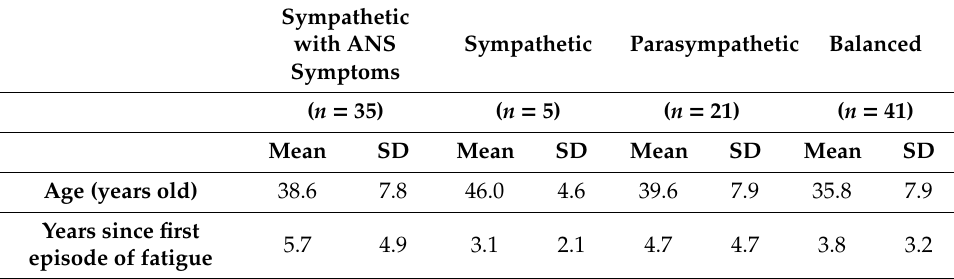
Table 6. Sociodemographic and clinical characteristics of each